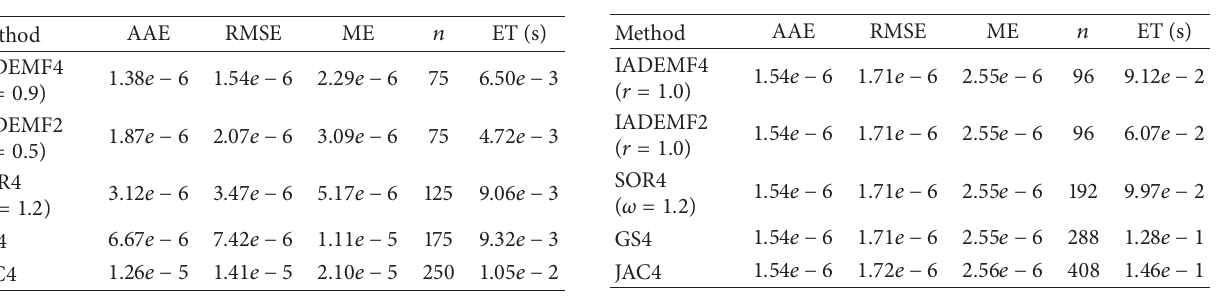
Table 9: Experiment 2. 𝑚 = 7000 , 𝜆 = 1.0 , Δ𝑥 = 1.43 × 10 −4 , Δ𝑡 = 2.04 × 10 −8 , 𝑡 = 5.1 × 10 −7 , and 𝜀 = 10 −10